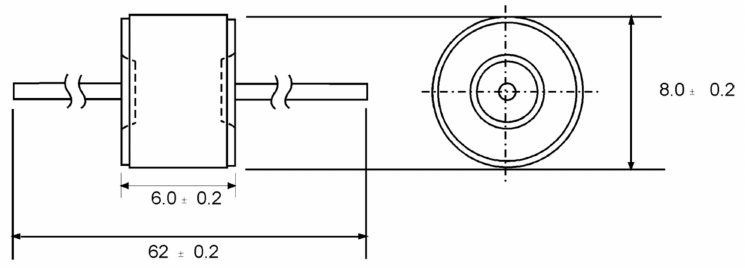
Figure 1. The geometry of gas-filled surge arrester. Table 1. Gas-filled surge arresters’ specifications at 25 ◦